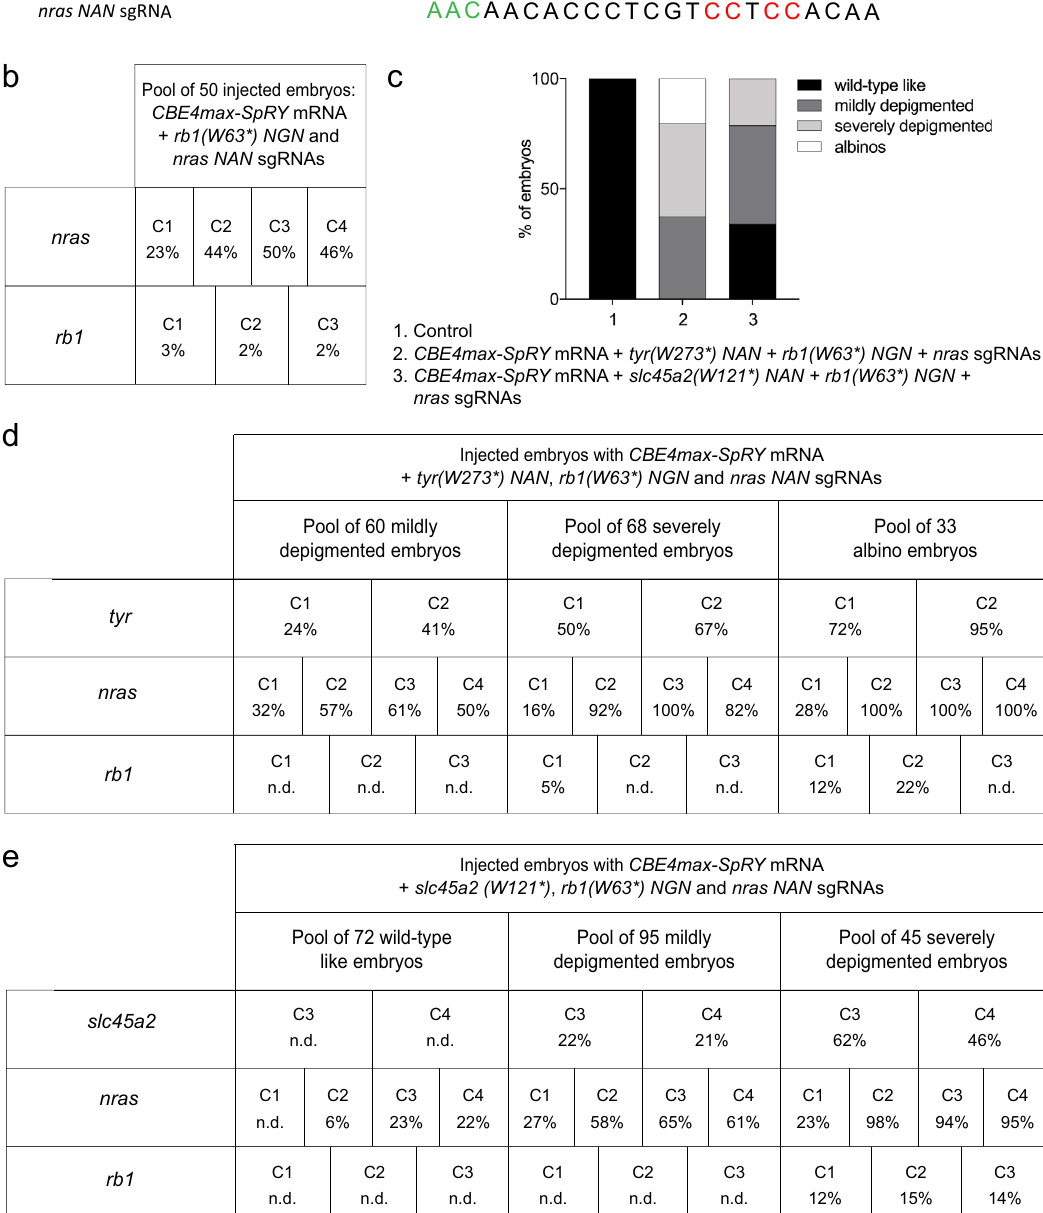
Pool of 33 albino embryos